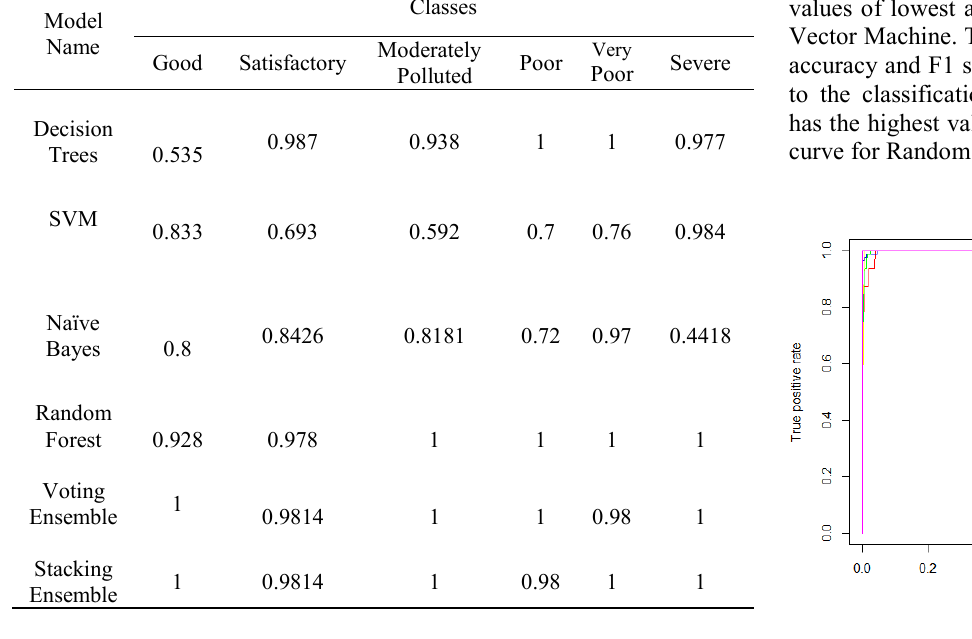
Figure 5. ROC Curve for Random Forest